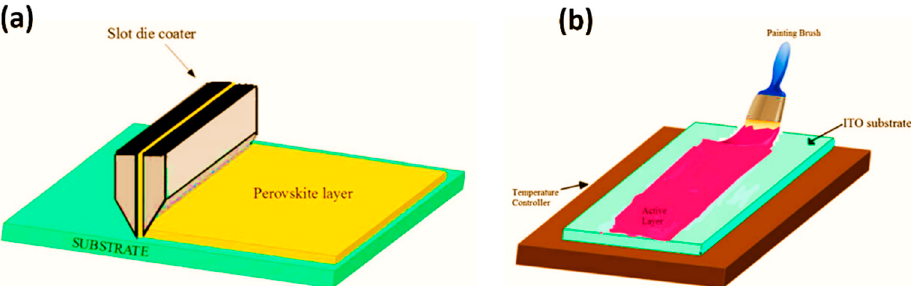
Figure 9. Perovskite layer deposition using ( a ) slot die coating, ( b ) brush painting techniques, for solar paint-based PSCs, respectively.